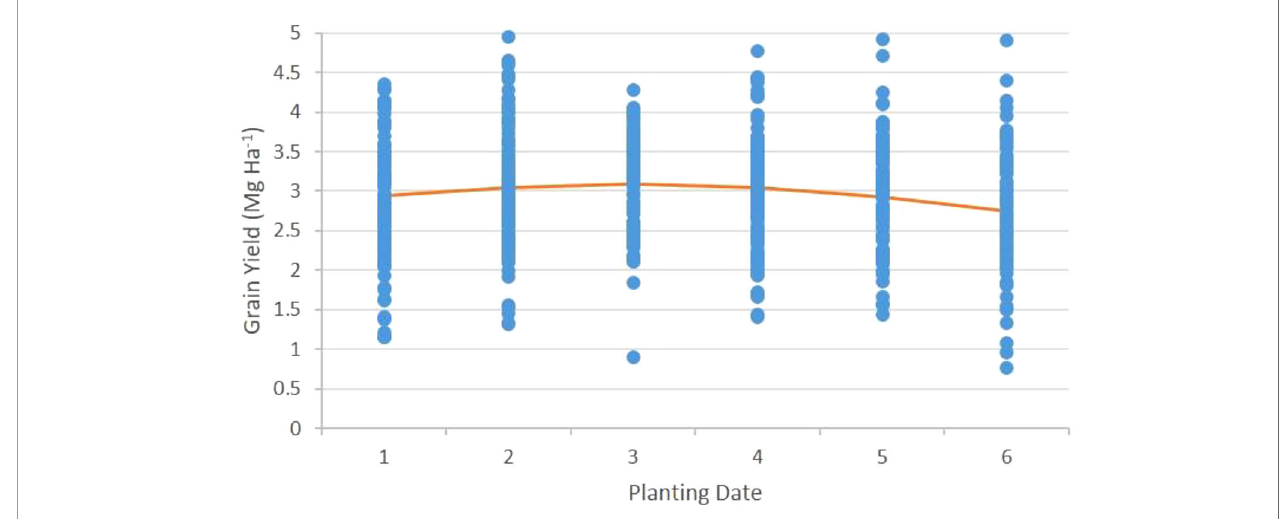
FIGURE 2 | Wheat grain yield as a function of planting date (PD) in sites south of 51°N latitude. PD 1 corresponds to a soil temperature of 0°C, or as soon after this trigger soil temperature as the site could be planted. Each successive PD corresponds to a 2°C increase in soil temperature from the previous PD.) The line represents a quadratic regression for grain yield [yield = 2.7709 + (0.2125 × PD) − (0.03624 × PD 2 ): R 2 = 0.61***] (***) Signi fi cant at P <